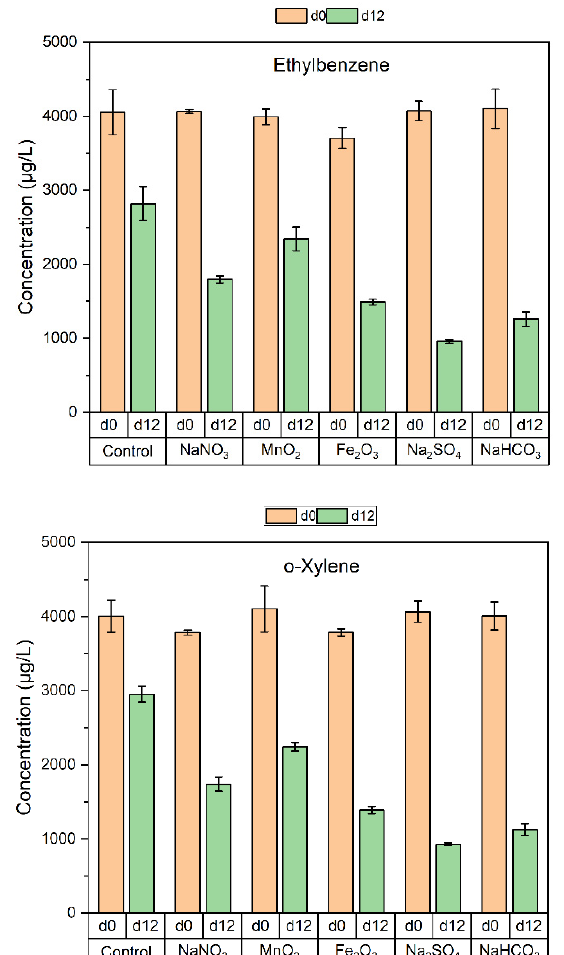
Figure 5. Comparisons of BTEX concentrations at the beginning (d0) and end (d12) of the microcosm study in the presence of various electron acceptors. Table 4. Biodegradation rate constants of BTEX in the presence of various electron acceptors (/d). Electron Acceptor Compound